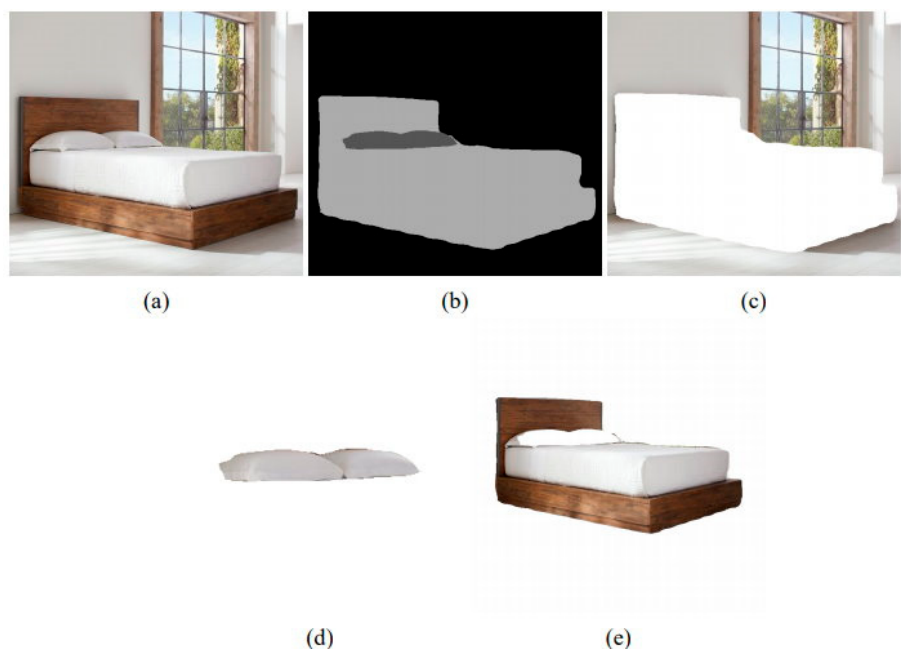
Figure 3. Segmenting the input image into objects: ( a ) the input image; ( b ) after clustering; ( c ) the background after erosion; ( d ) the pillows; and ( e ) the bed.